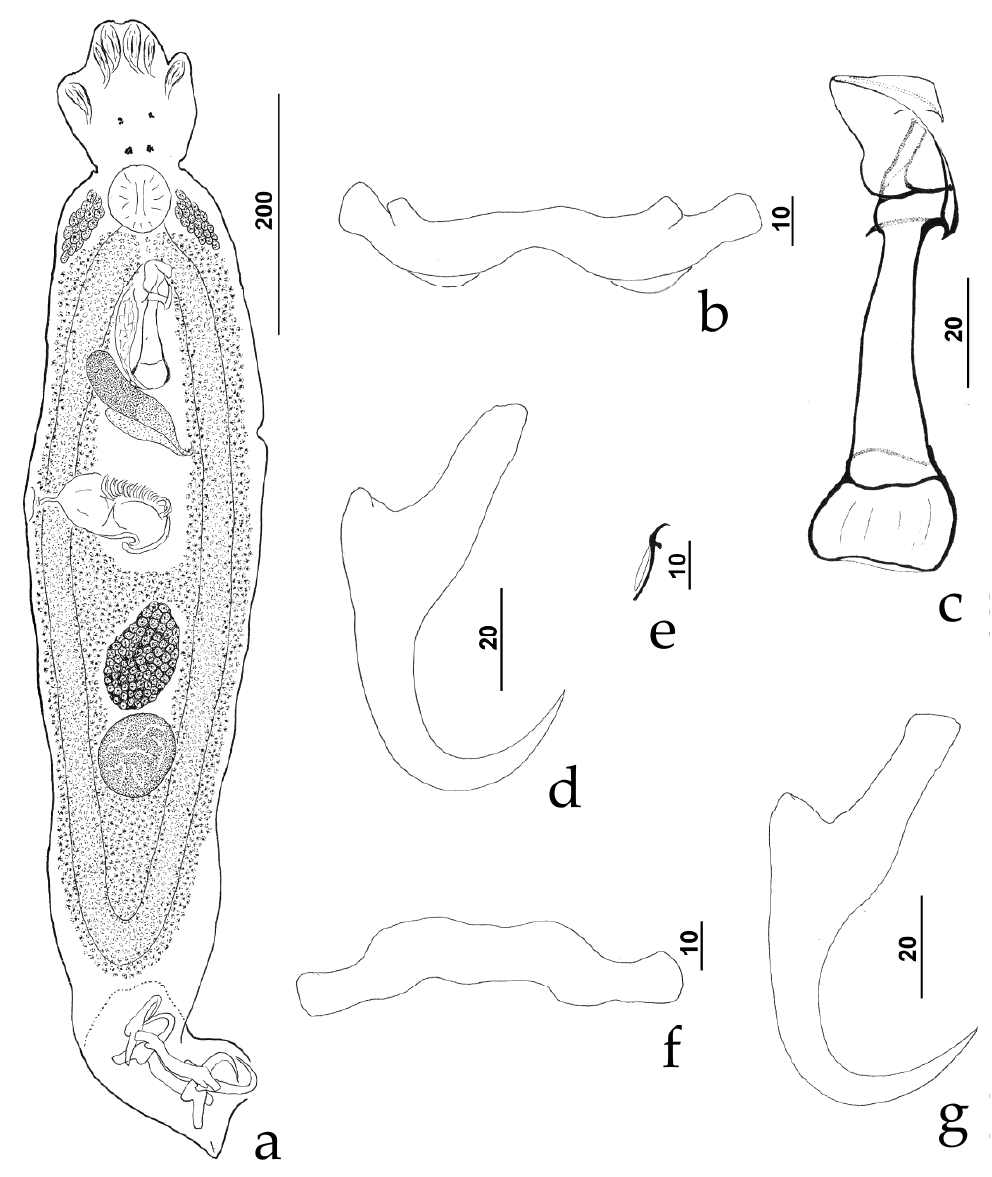
Figure 4. Platycephalotrema austrinum n. sp. ( a ). Whole mount (composite; body, ventral view; haptor, dorsal view); ( b ). dorsal bar; ( c ). male copulatory organ (ventral view); ( d ). dorsal anchor; ( e ). hook; ( f ). ventral bar. ( g ). ventral